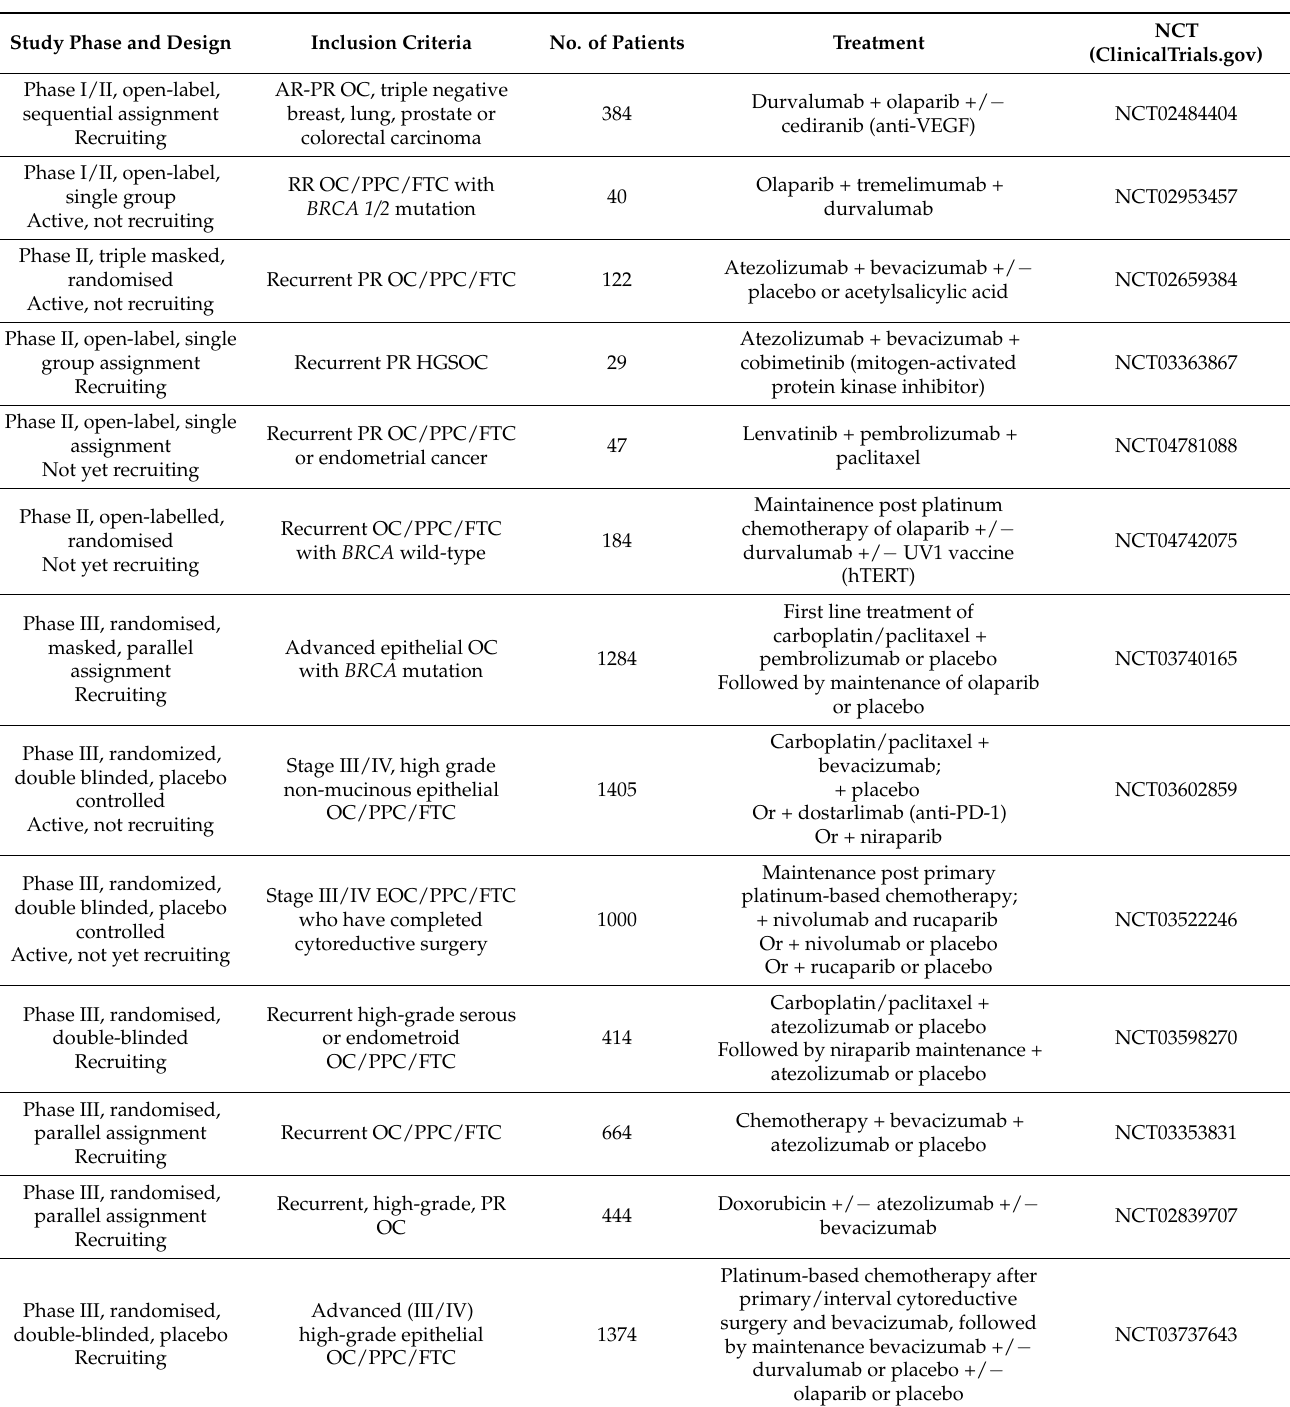
Table 1. Clinical trials in OC using immune checkpoint inhibition in combination with two other therapies. Advanced recurrent (AR), Platinum-resistant (PR), Recurrent or refractory (RR), Ovarian cancer (OC), Primary peritoneal cancer